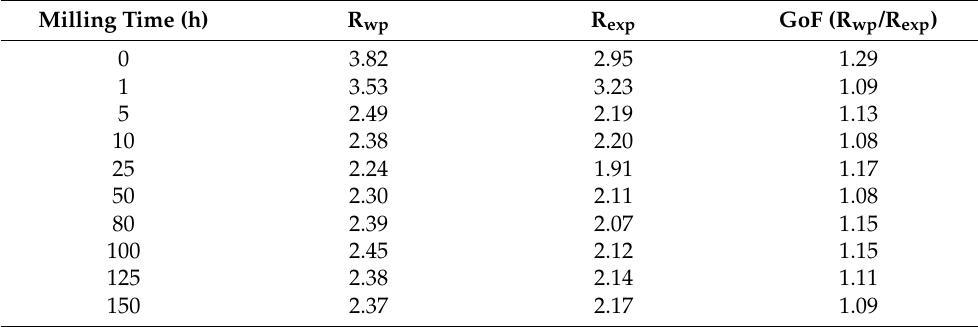
Figure 1. Scanning electron micrographs corresponding to mechanically milled powders: ( a ) 0 h, ( b ) 5 h, ( c ) 25 h, ( d ) 50 h, ( e ) 100 h and ( f ) 150 h. The bar scale of the images (except inserts: 9 µm) is 40 µm. Table 1. Residual parameters and GoF values of the compounds revealed from Rietveld analysis.